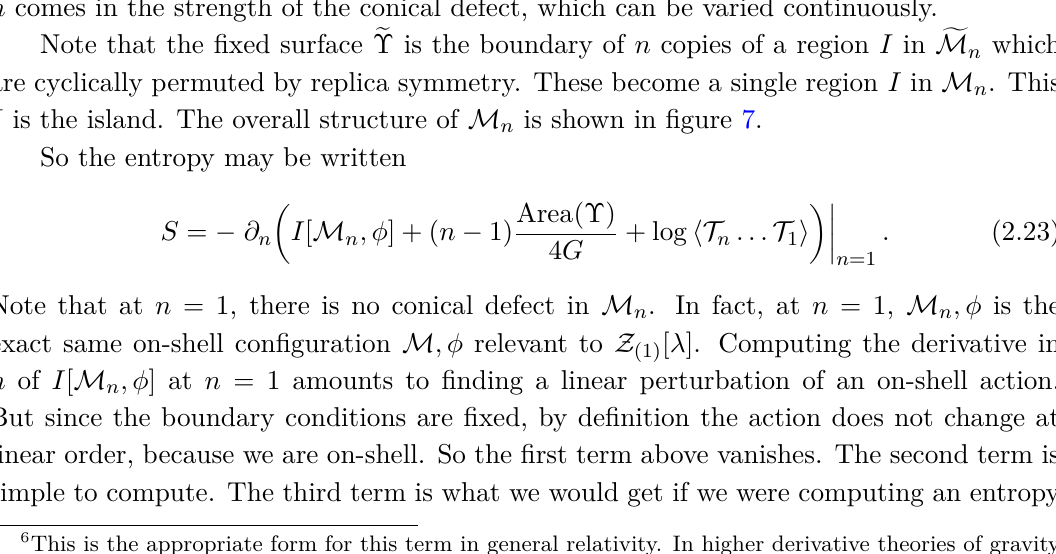
Figure 6. The on-shell configuration for Z general there will be a codimension 2 surface e Υ in the gravitational region which is fixed by Z n , here shown as two points. e Υ is the boundary of n copies of a codimension 1 surface I , which are cyclically permuted by Z n